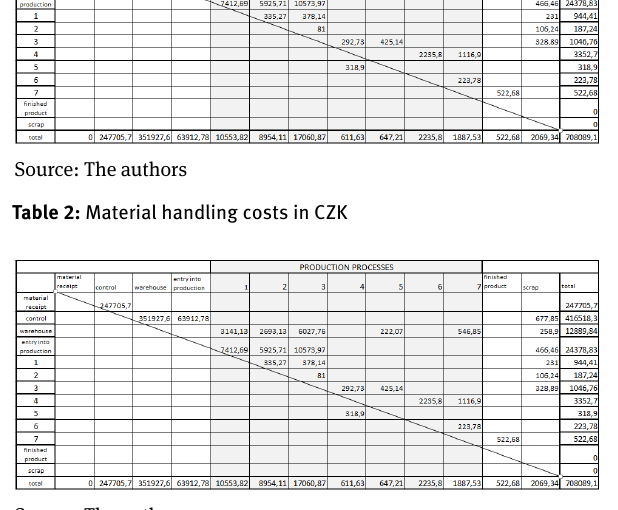
Table 3: Distances between the objects in meters